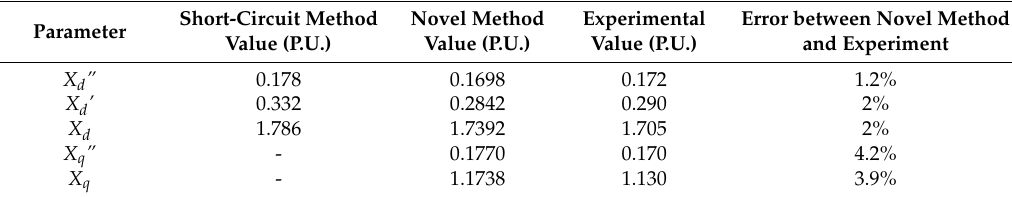
Table 4. External Circuit Parameters.